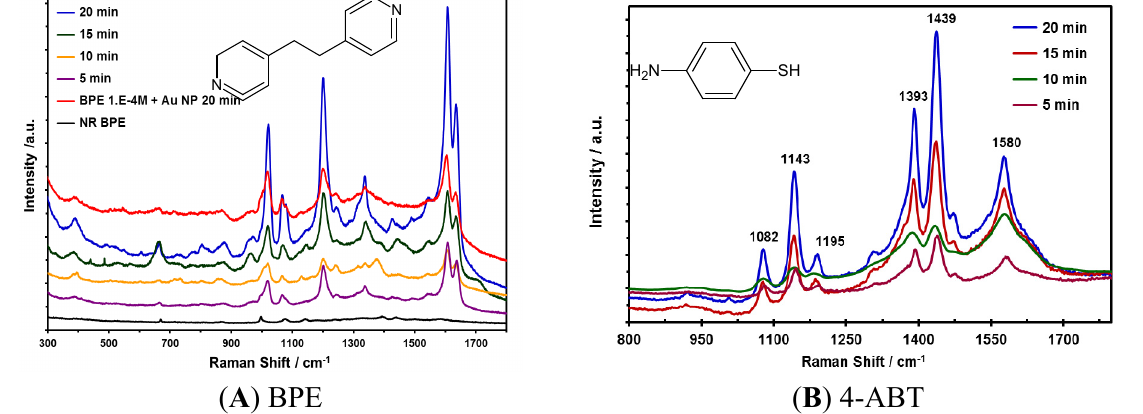
Figure 3. Surface enhanced Raman scattering (SERS) spectrum of ( A ) 1 mM BPE in Au NPs at various irradiation times. Raman and SERS spectra were acquired at 785 nm. ( B ) 1 mM 4-ABT deposited on Ag NPs deposited on Au-coated glass slide at various irradiation times. SERS spectra were acquired at 532 nm.